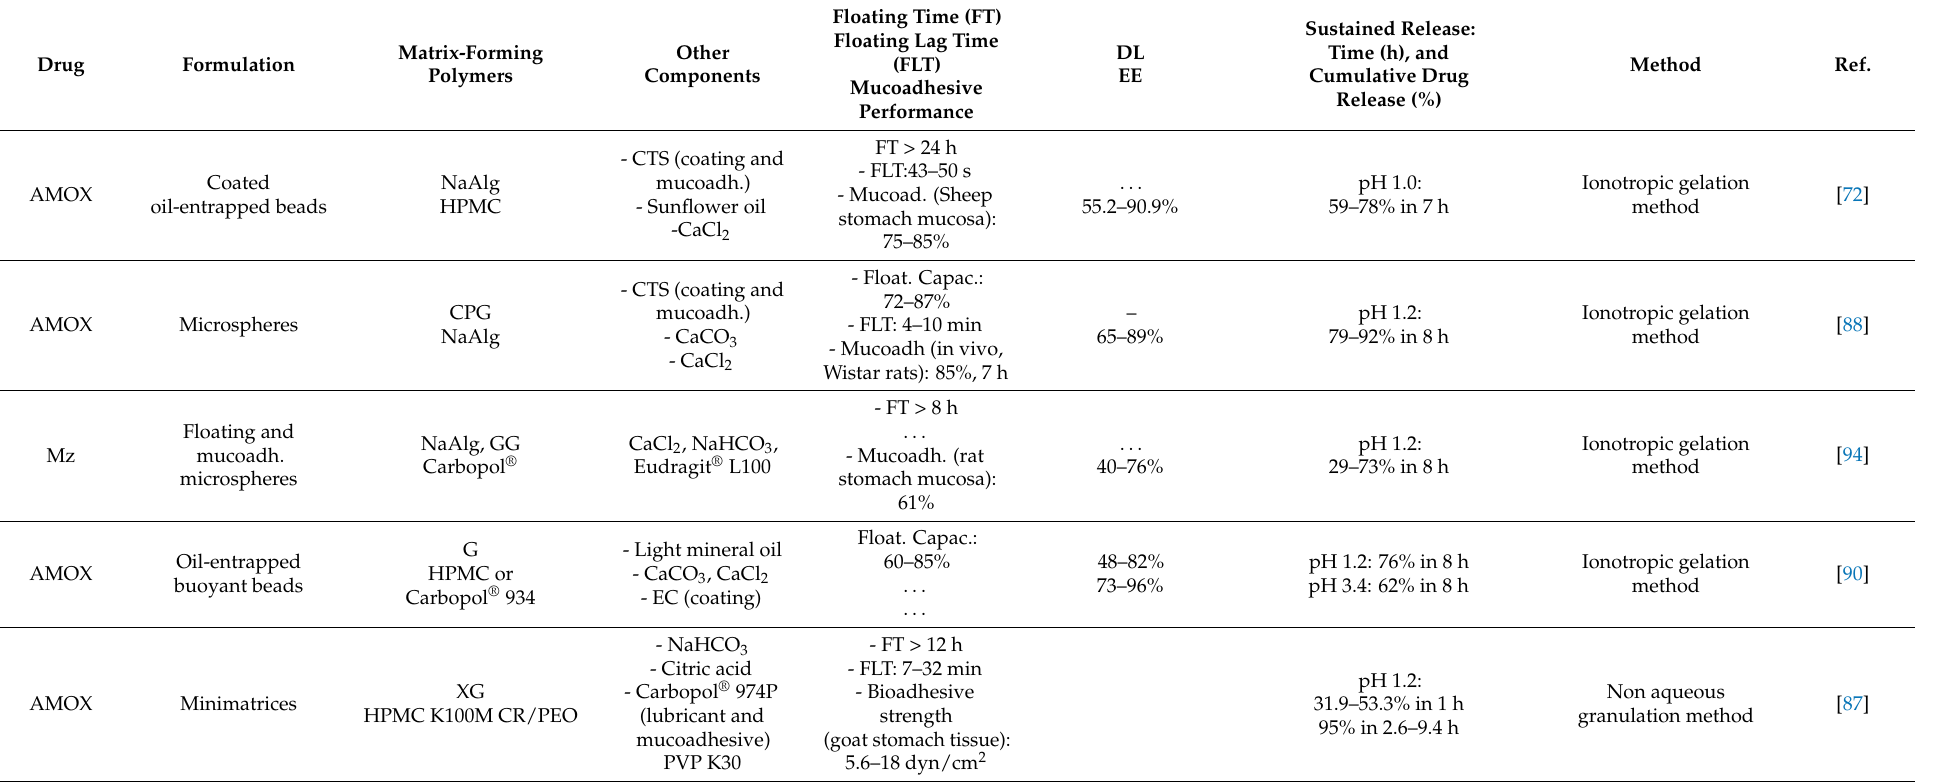
Table 5. Selected AMOX-loaded floating and mucoadhesive formulations used in the treatment of infections by H. pylori